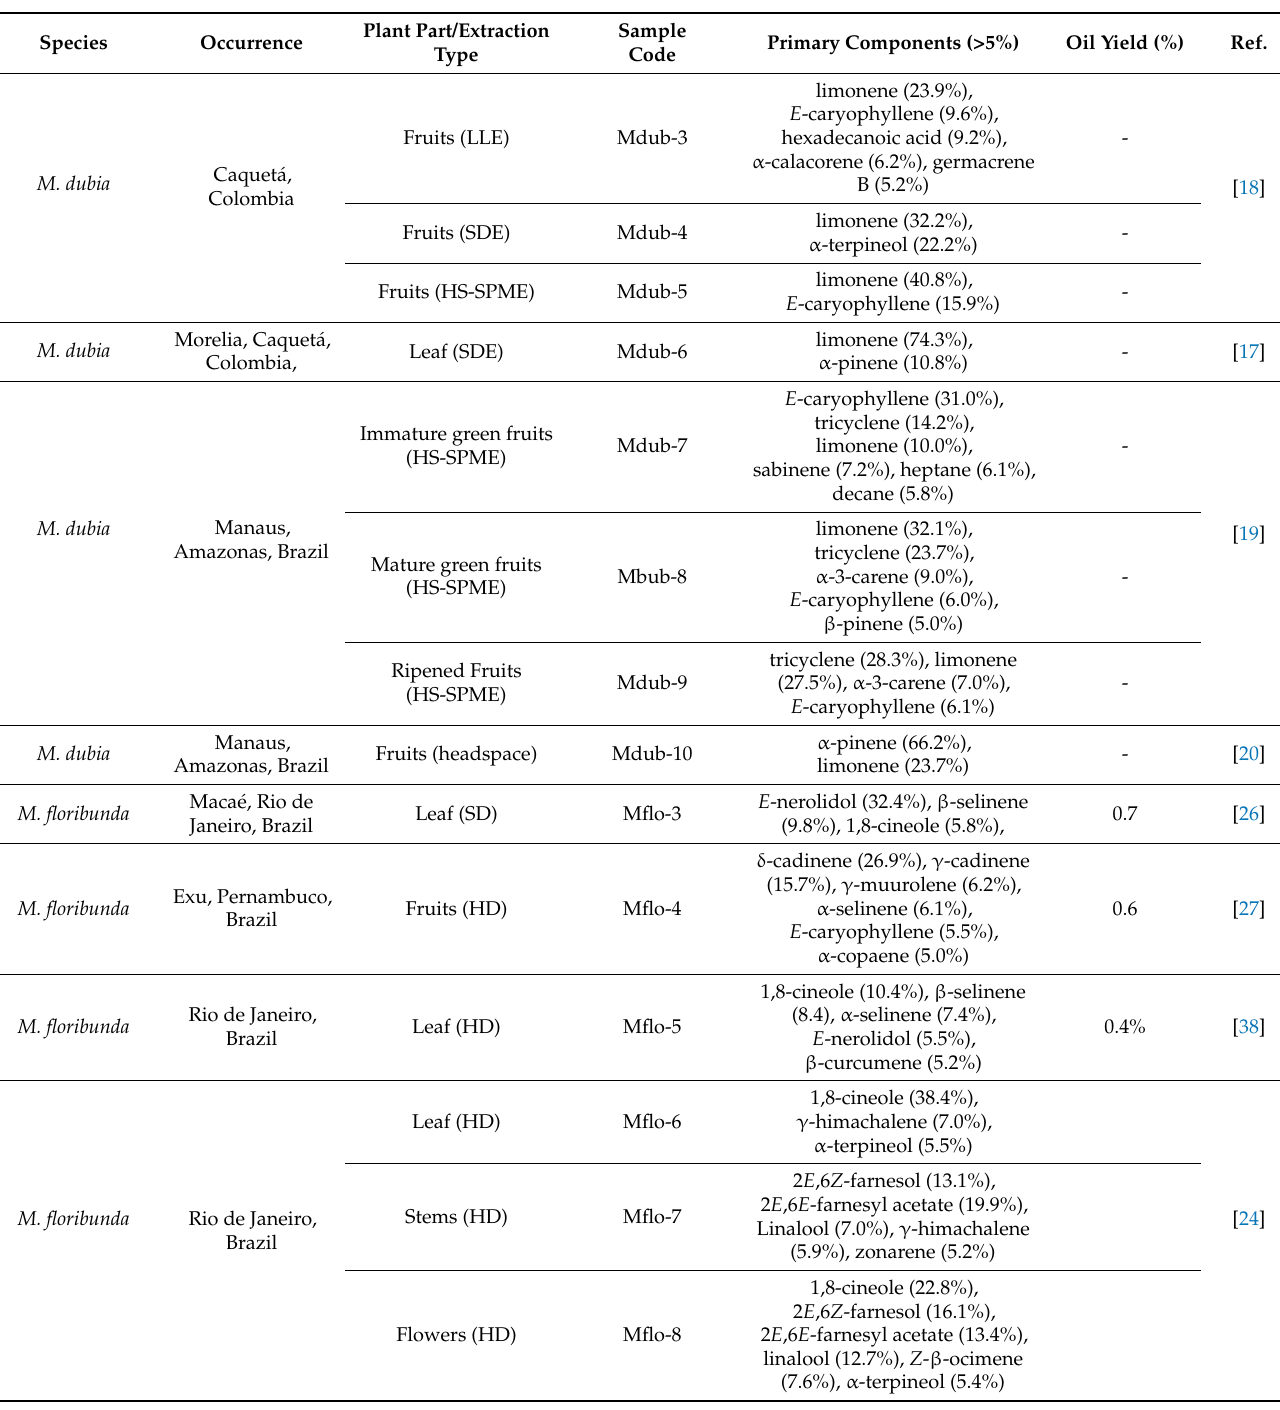
Table A1. Volatile composition of Myrciaria